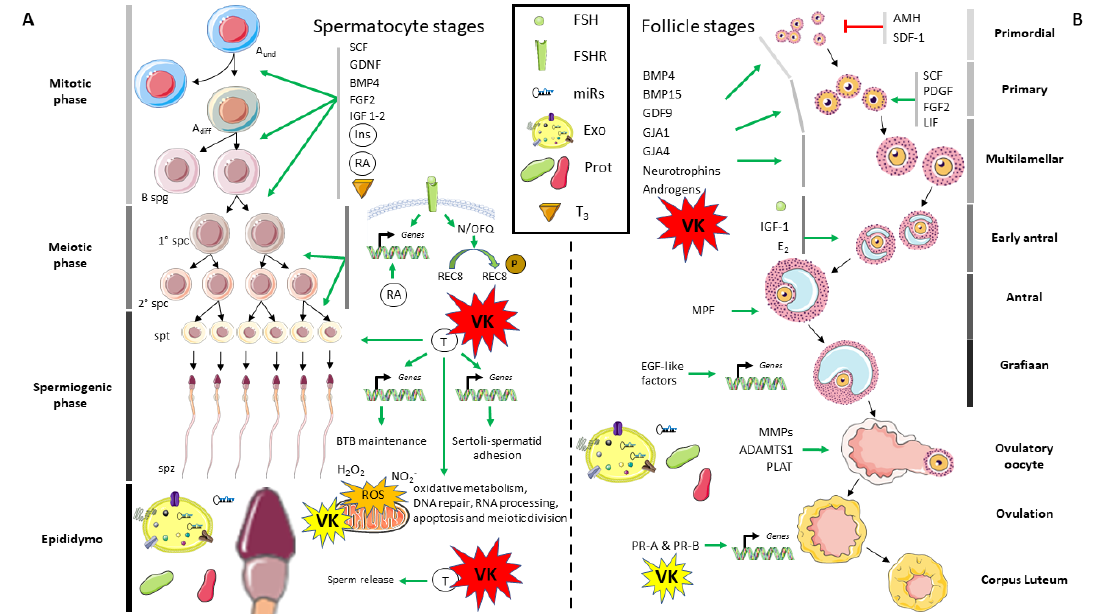
Figure 3. Gonad development and related molecular pathways in vertebrates . General overview of spermatogenesis ( A ) and oogenesis ( B ), specifying some of the most relevant pathways. The particular mechanisms by which vitamin K (VK) has a demonstrated effect on gonad development are highlighted in red, while those showing potential evidences are highlighted in yellow. ADAMTS1 , a disintegrin-like and metallopeptidase with thrombospondin type 1 motif, 1; A diff , differentiated spermatogonia A; AMH , anti-M ü llerian hormone; A und , undifferentiated spermatogonia A; B spg , spermatogonia B; BMP4 , bone morphogenetic protein 4; BMP15 , bone morphogenetic protein 15; BTB , blood-testis barrier; E 2 , estradiol; EGF-like factors , epidermal growth factor-like factors; FGF2 , fibroblast growth factor 2; FSH , follicle-stimulating hormone; FSHR , follicle-stimulating hormone receptor; GDF9 , growth differentiation factor 9; GDNF , glial cell-derived neurotrophic factor; GJA1 , gap junction alpha-1 protein; GJA4 , gap junction alpha-4 protein; IGF 1-2 , insulin like growth factor 1 and 2; Ins , insulin; LIF , leukemia inhibitory factor; MMP , matrix metalloproteinases; MPF , maturation-promoting factor ; N/OFQ , nociceptin/orphanin FQ; P in brown circle , phosphorylated protein; PDGF , platelet-derived growth factor; PLAT , tissue -type plasminogen activator ; PR-A, progesterone receptor A; PR-B , progesterone receptor B; RA , retinoic acid; REC8, meiotic recombination protein REC8 homolog; SDF-1/CXCL12 , stromal cell-derived factor-1; SCF, stem cell factor; spt , spermatid; spz , spermatozoa; 1° spc , primary spermatocyte; 2° spc , secondary spermatocyte; T , testosterone; T 3 , triiodothyronine.